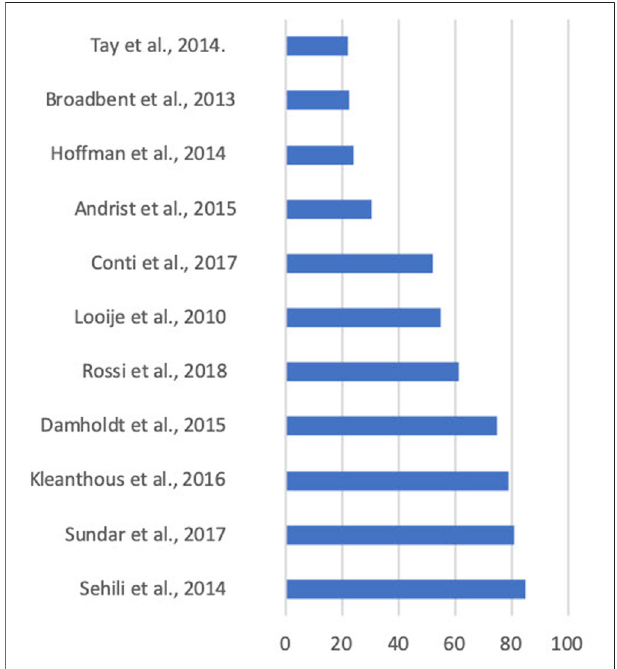
FIGURE 5 | Average participant age by